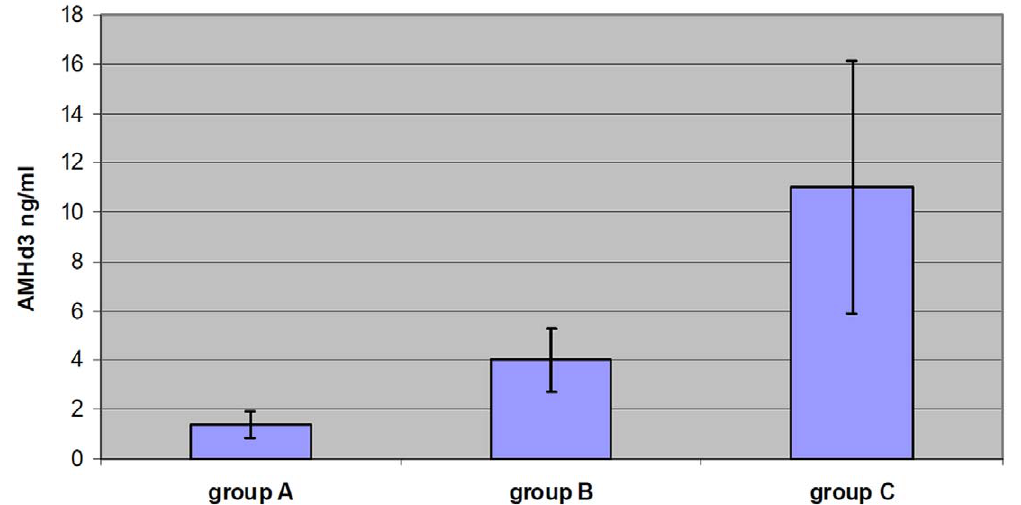
Figure 2. values of AMHd3 and their 95% confidence intervals according to response group. Notes: group A = poor responders; group B = normal responders; group C = high responders; AMH group B vs AMH group A: P , 0,001; AMH group B vs AMH group C: P , 0,001.